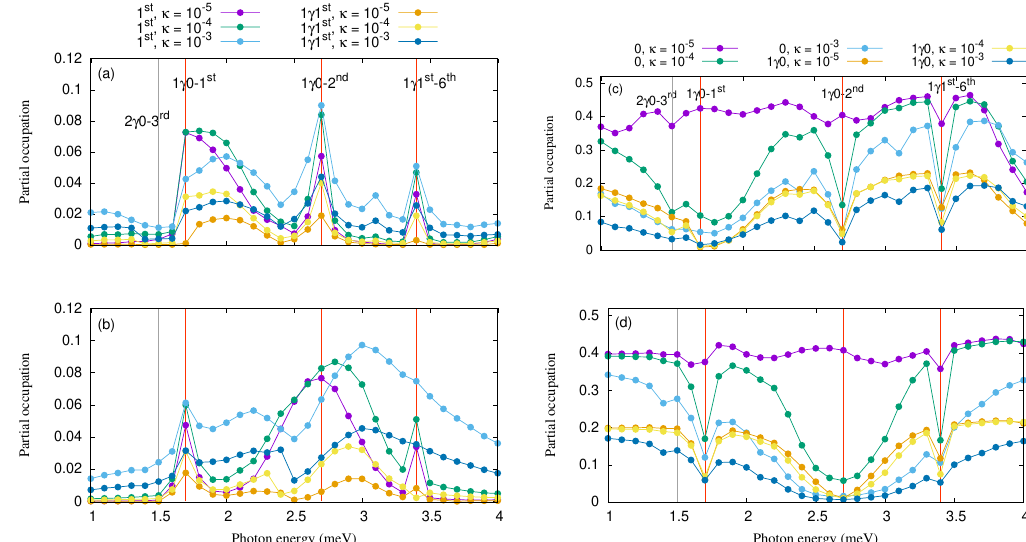
Figure 5. The partial occupation of the spin-up component of 1st and 1 γ 1st for different cavity–reservoir coupling is plotted x - ( a ) and y -polarized photon field ( b ). Furthermore, the partial occupation of the spin-up component of 0 and 1 γ 0 for different cavity–reservoir coupling is presented for x - ( c ) and y -polarized photon field ( d ). The cavity–reservoir coupling is assumed to be κ = 10 − 5 (purple for 0, and brown for 1st), 10 − 4 (green for 0, and yellow for 1st), and 10 − 3 (light blue for 0, and dark blue for 1st) in the case of x - ( a ) and y -polarized ( b ) photon field with g γ = 0.1 meV, and n R = 1. The vertical red lines indicates the positions of the resonance states. The chemical potential of the leads are µ L = 1.65 meV and µ R = 1.55 meV. The magnetic field is B = 0.1 T, eV g = 0.651 meV, T L,R = 0.5 K, and ¯ h Ω 0 = 2.0 meV.